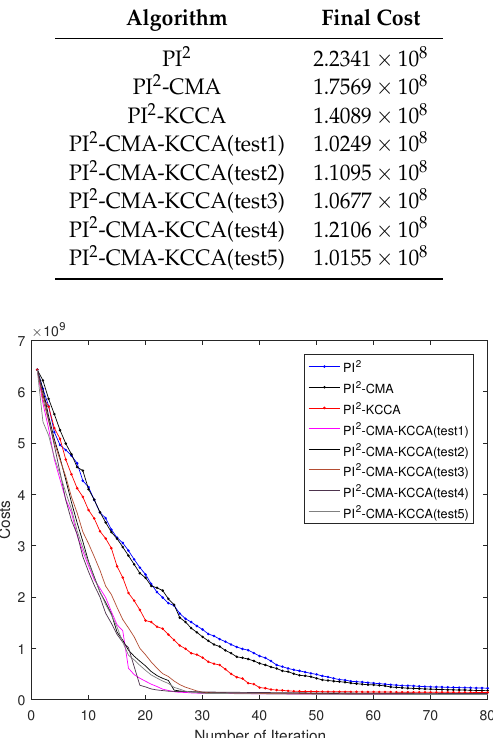
Table 2. The final cost of one via-point task with SCARA. Algorithm